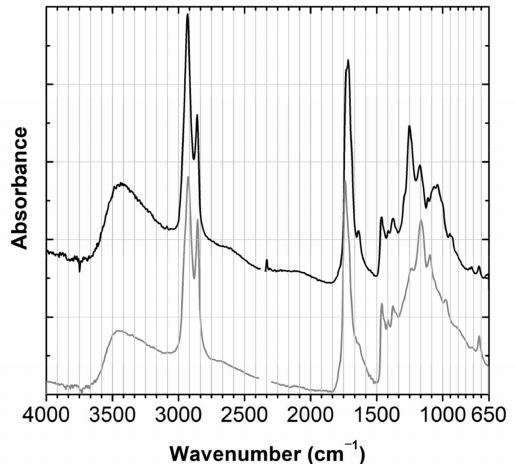
Figure 8. Infrared spectrum of the varnish applied over the white color (black) compared with a linseed oil reference (grey).